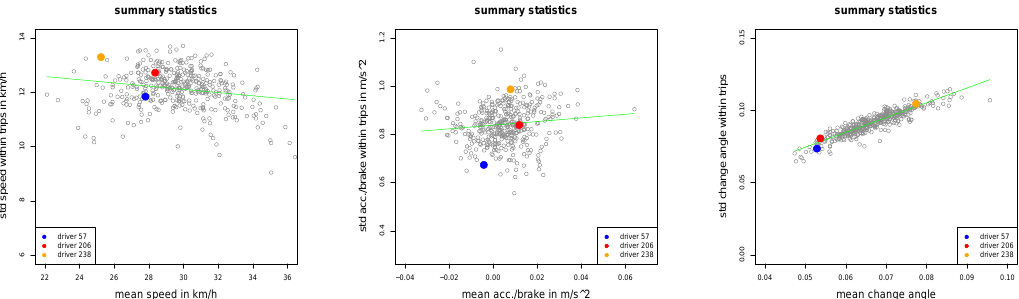
Figure 3. Empirical standard deviations (2) plotted against empirical means (1) for all n = 416 drivers.